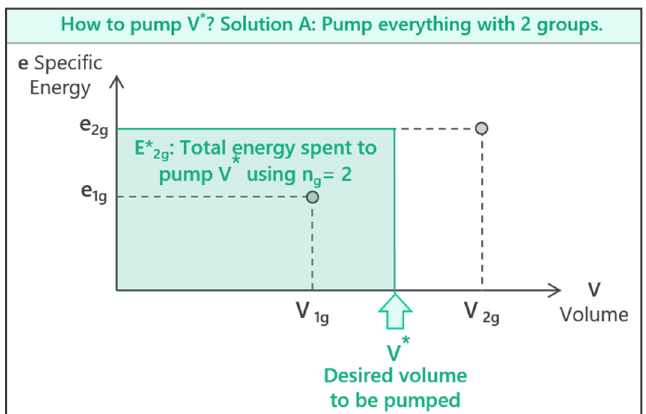
Figure 4. Solution A. Pump all V* with two pumps.